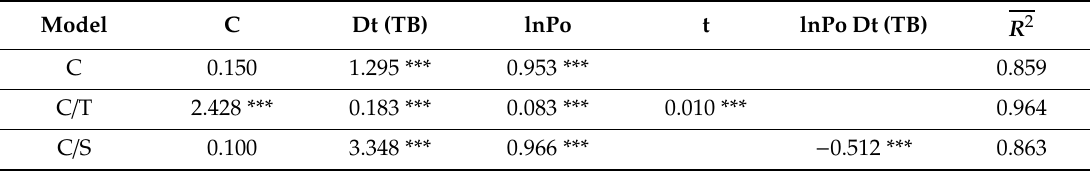
Table 7. Gregory–Hansen cointegration test